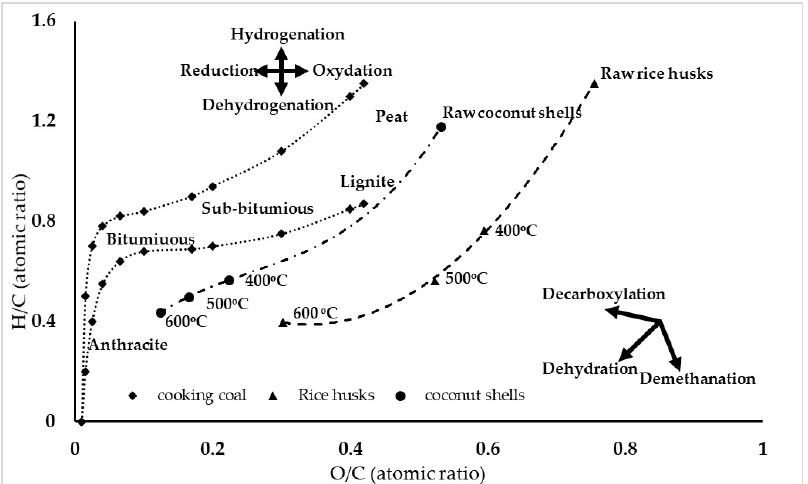
Figure 4. Van Krevelen diagram of coal and biochar.